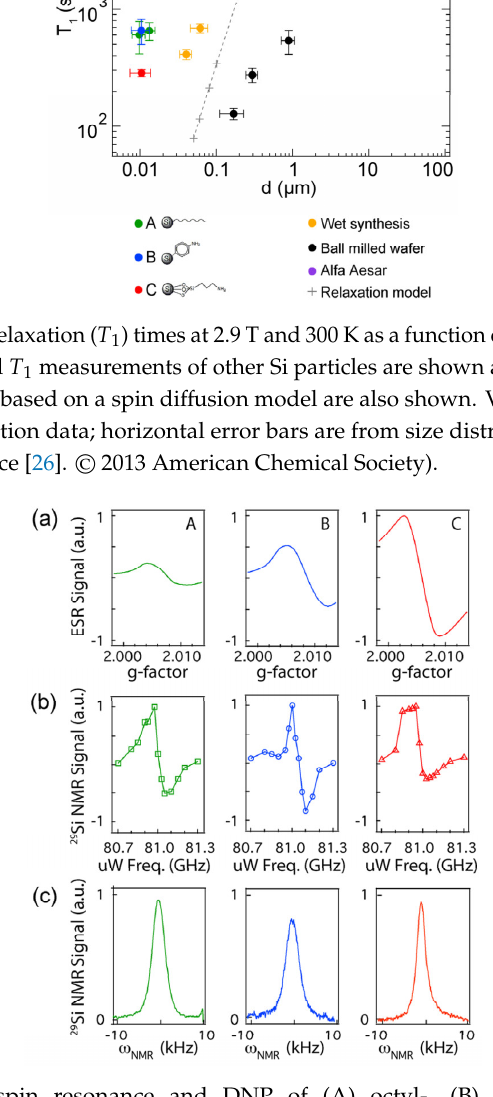
Figure 12. Electron spin resonance and DNP of (A) octyl-, (B) 4-aminophenyl- and (C) APTMS-terminated Si NPs. ( a ) Electron spin resonance signal and ( b ) 29 Si nuclear polarization as a function of microwave frequency under DNP conditions. ( c ) 29 Si NMR spectra obtained under DNP conditions. (Reprinted with permission from Reference [26]. © 2013 American Chemical Society).